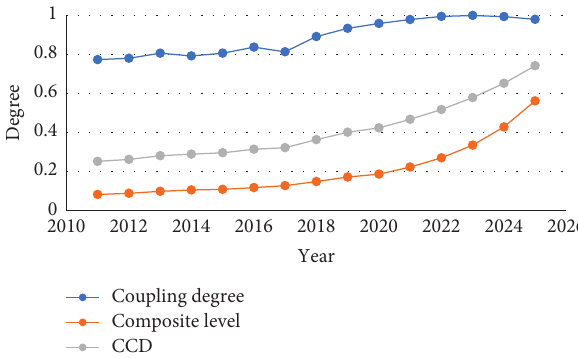
Figure 2: Couling degree, composite level, and CCD of economy and